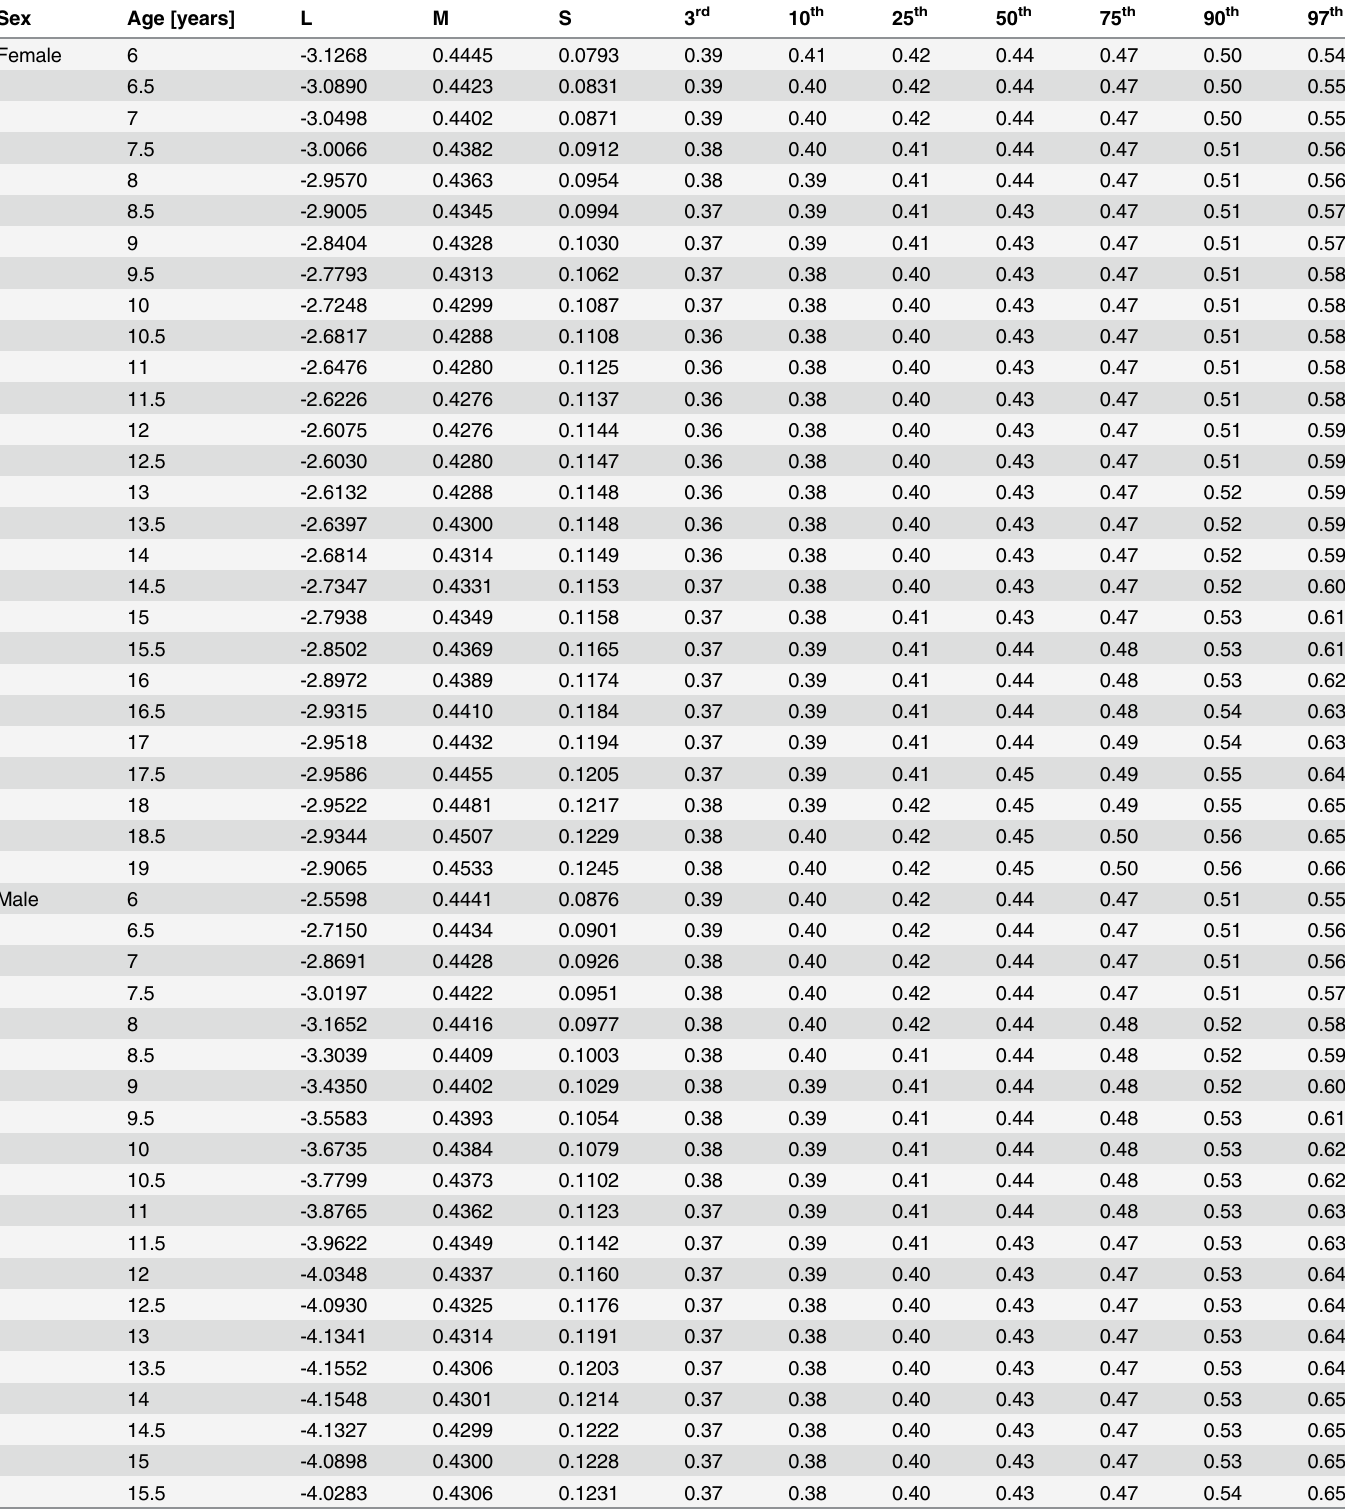
Table 4. L, M, and S values, and percentiles of waist-to-height ratio by age and sex for Canadian children and youth aged 6 to 19